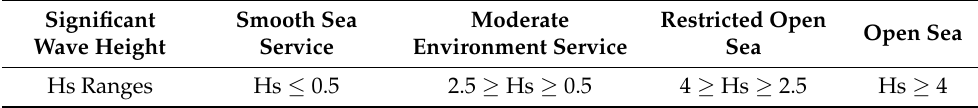
Table 8. Sea state–wave height relations summary